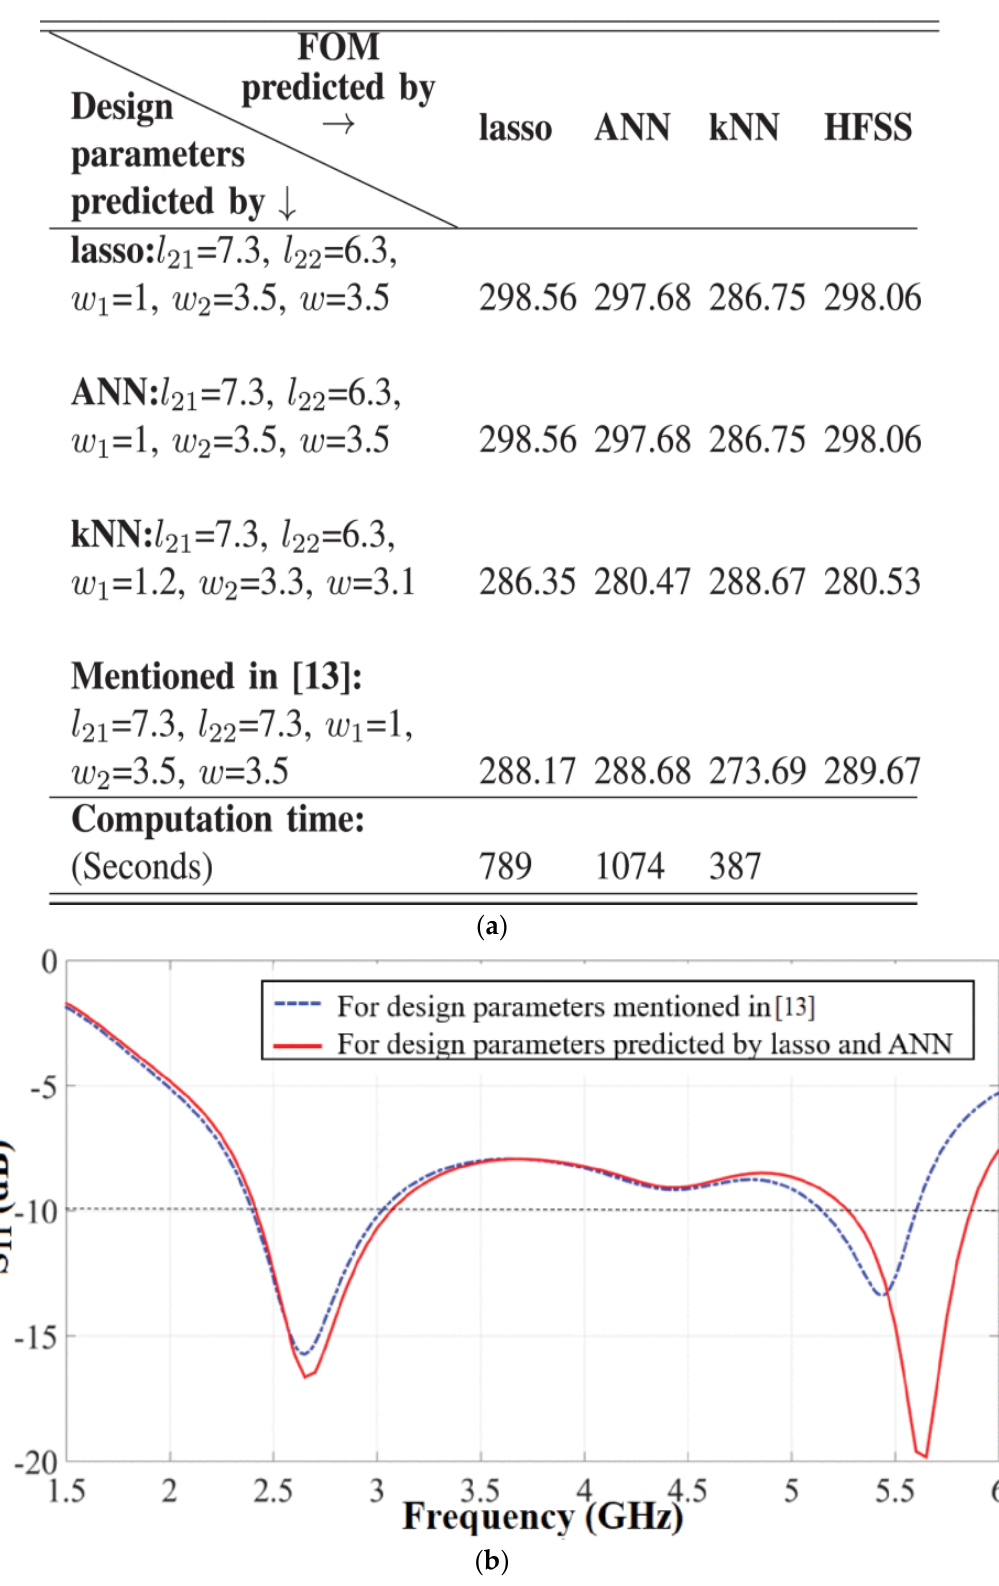
Figure 4. ( a ) Comparison of different ML algorithms based on computational time and figure of merit for different ML techniques, and ( b ) comparison of S 11 parameter predicted by ML techniques with respect to the reference design parameters [59].